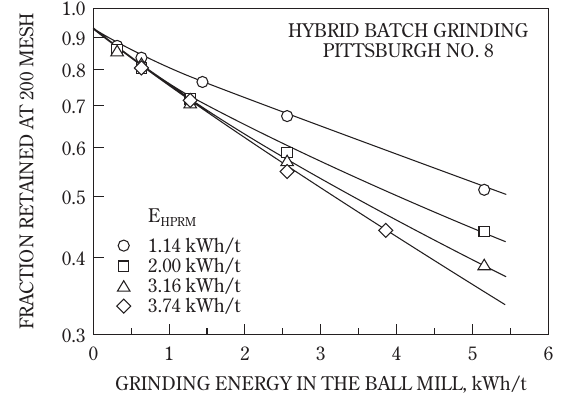
Fig. 9 For the hybrid grinding of Pittsburgh No. 8 coal, the frac- tion retained on a 200-mesh sieve (74 µ m) sieve as a func- tion of the energy expended in the ball mill on material that had been comminuted in the high-pressure roll mill at different HPRM energy levels: experimental data points and simulated curves.